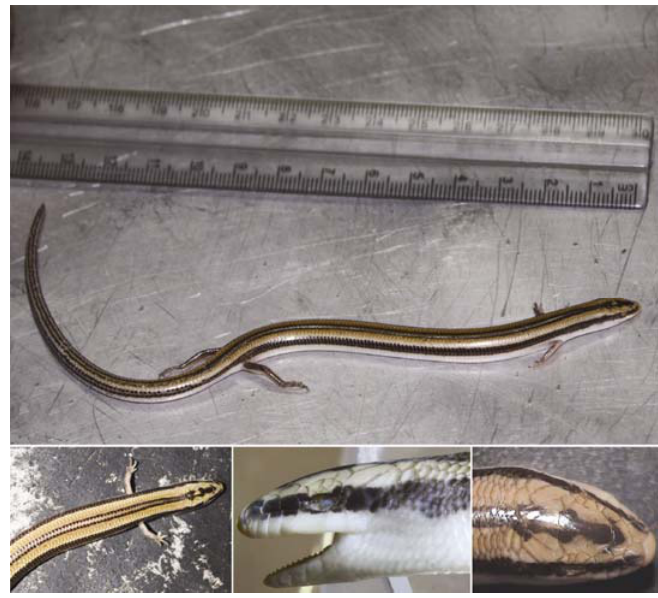
F IGURE 2. Ophiomorus nuchalis (ZMGU. 2580). Photograph by M. Farhadi.